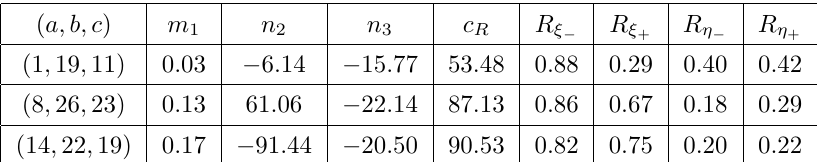
= c sugra (divided by ( g (cid:0) 1) N 2 ) and the R